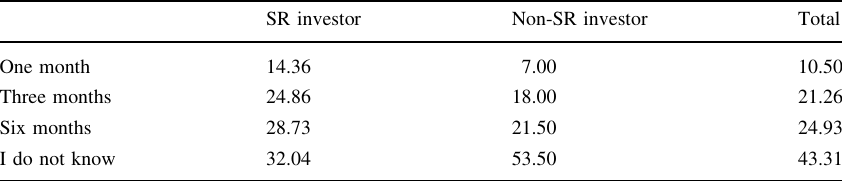
Table 12 Financial markets are changing fast. It is not always possible to assess each proposed investment with respect to its compliance with sustainability. In terms of the compliance of sustainability, within which time horizon is a review reasonable?